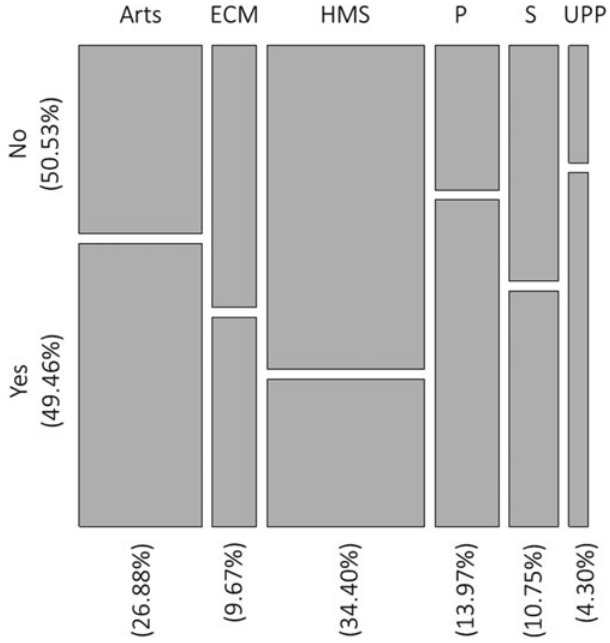
Fig. 9. Mosaic plot representing associations between faculty and mentoring services. The mosaic plot shows the marginal percentages in each faculty. ECM, Faculty of Engineering, Computer, and Mathematical Sciences; HMS, Faculty of Health and Medical Sciences; P, Faculty of Professions; S, Faculty of Science; UPP, University Preparatory Programme.